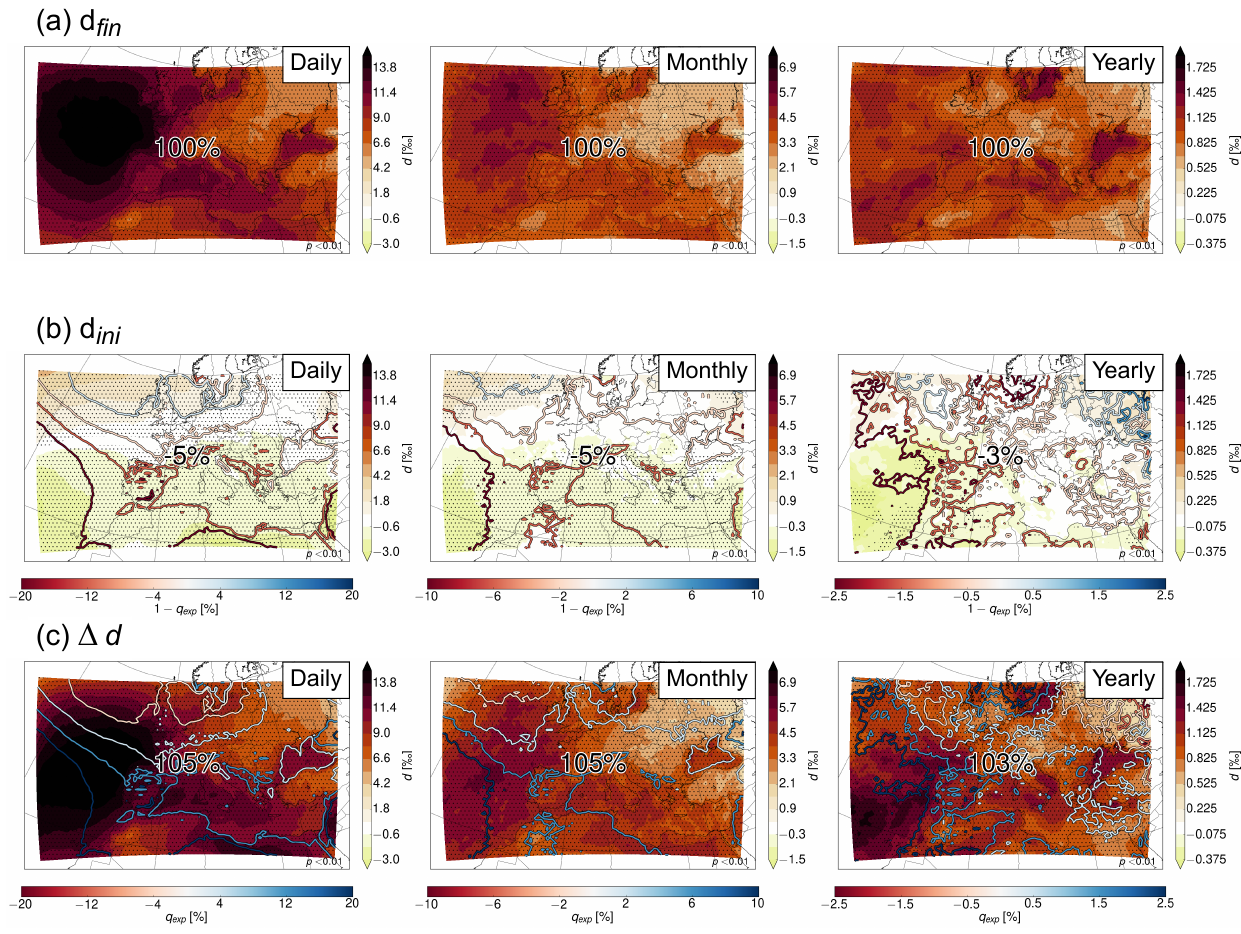
Figure 12. Difference in deuterium excess between the high and low anomaly days (left), months (middle), and years (right) at each grid point. (a) Shows the mean deuterium excess in water vapour averaged over the first, third, and fifth lowest model level and (b, c) show the weighted contributions of the initial values and the changes along the trajectories, respectively. The numbers show the mean contribution of each term to d fin , and the contours show the difference in 1 − q exp (b) and q exp (c) in %. Stippling indicates areas where p < 0 . 01. Note the different colour